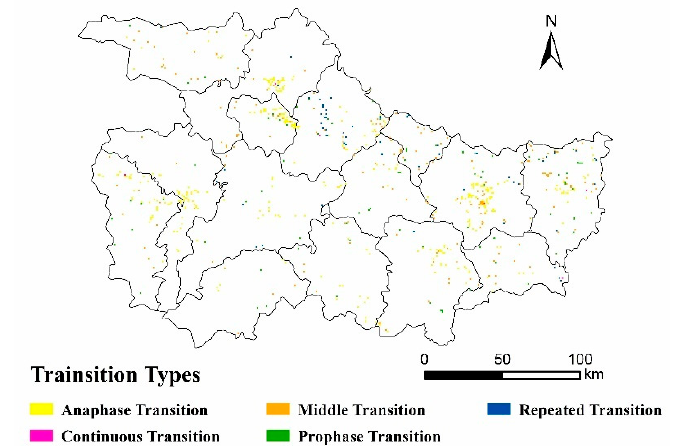
Figure 4. Pattern Tupu of land use change during 1990–2015 in the Exibei region. Anaphase transition type: land use type only changes in 2010–2015.; middle transition type: land use type only changes in 1995–2010.; repeated transition type: more than two kinds of land types changed in 1995–2010, and land use type remained the same in 1990 and 2015; continuous transition type: there were at least three land use types in 1990–2015, and land use type was di ff erent in 1990 and 2015.; prophase transition type: land use type only changes in